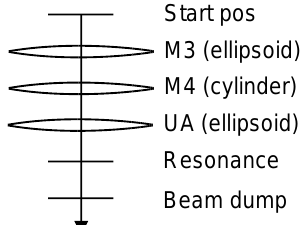
Fig. 2. Beam path of the U-beams from the launcher to the beam dump